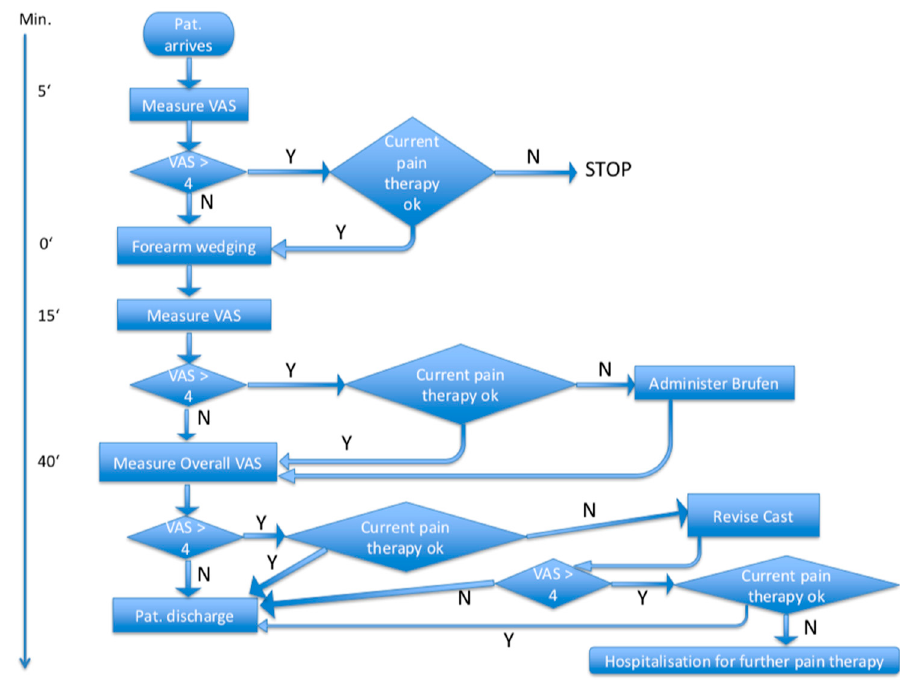
Figure 1. Flowchart of timetable and pain management (N: no, Y: yes). VAS: visual analog scale.